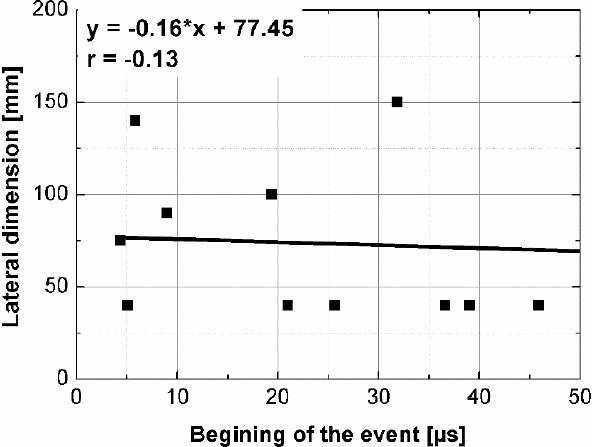
Figure 17. The beginning of the main event plotted against minimal lateral dimension.